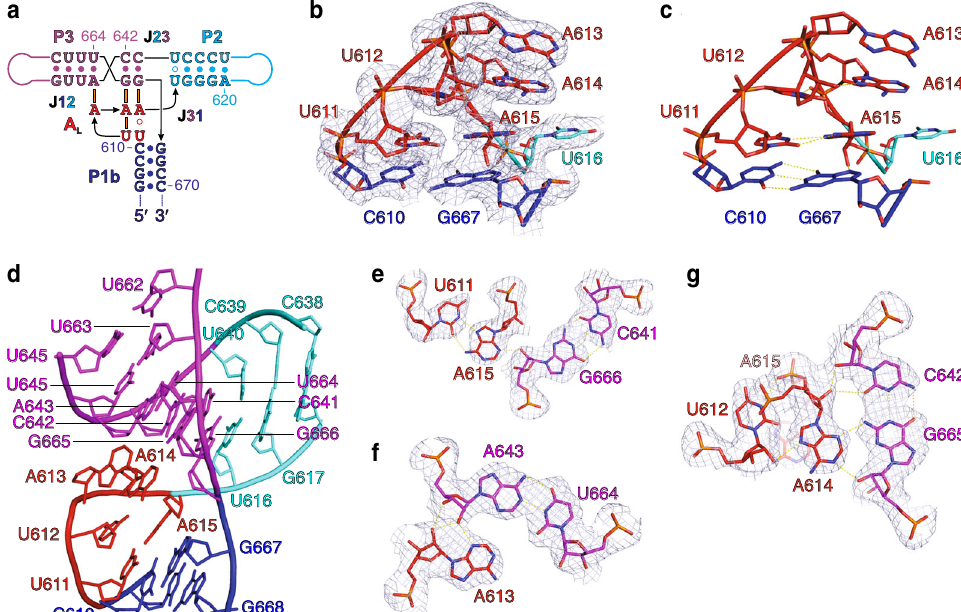
Fig. 4 Structure of the A L and organization of the three-way junction. a Overall secondary structure of the A L and the three-way junction. Solid and hollow circles depict canonical and non-canonical base-pairing interactions, respectively, and orange bars indicate the tertiary interactions. b Structure of the A L and c interactions within the A L . d Structural organization of the three-way junction in which the dinucleotide stack of A613 and A614 from A L interacts with the minor groove of the helix P3. e – g Three base-triples that stabilize the junction involving the A L nucleotides and the minor groove of the helix P3. Dashed lines in c and e – f represent heteroatoms within the hydrogen bonding distance (2.5 – 3.5 Å). Blue mesh in b and e – g represents the 2| F o | − | F c | electron density map at 1 σ contour level and carve radius 1.8